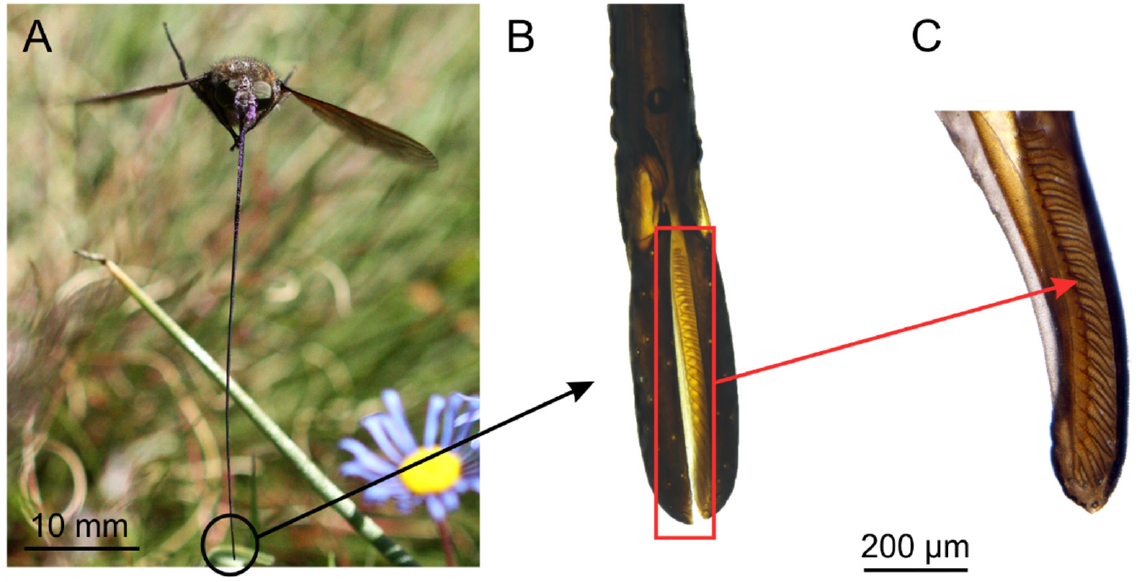
Figure 2. The long-proboscid fly P. marinusi (Nemestrinidae) and morphology of the proboscis tip; ( A ) Proboscis in feeding position; ( B ) Proboscis tip formed by pair of labella; ( C ) Median view of labellum shows pseudotrachea canals for nectar uptake through apical end of proboscis. Table 1. Body size and proboscis morphometry of Prosoeca marinusi (Nemestrinidae) from the population of the study site